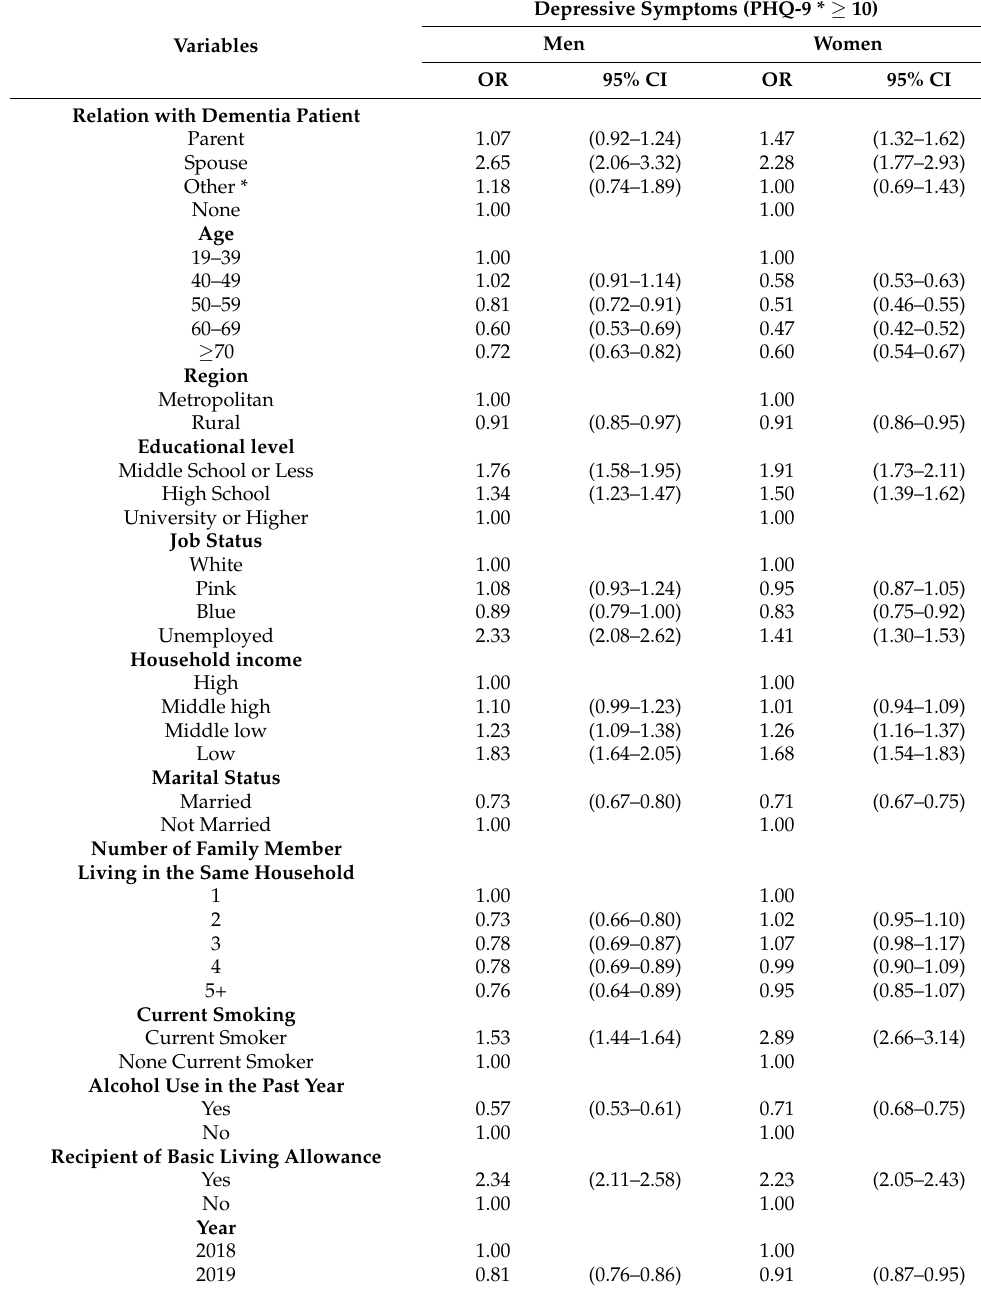
Table 2. Associations between depressive symptoms (PHQ-9) and participants